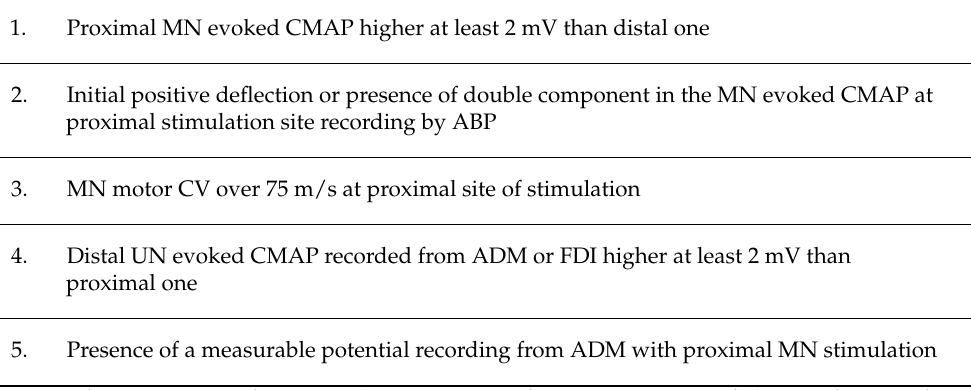
Table 2. Electrodiagnostic criteria for median-to-ulnar communicating